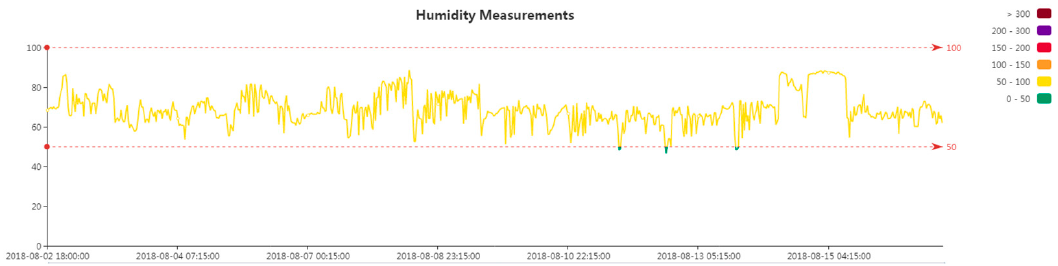
Figure 11. Indoor Humidity.